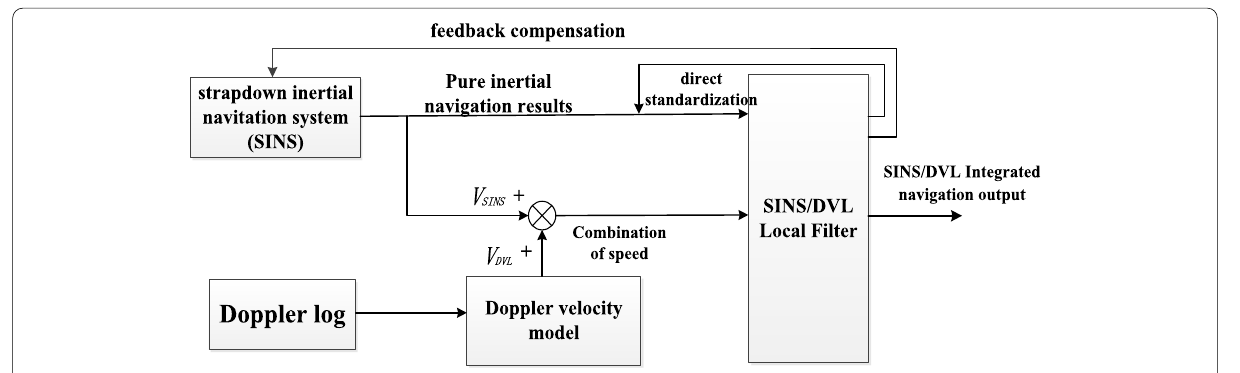
Fig. 3 The framework of the integrated SINS/DVL